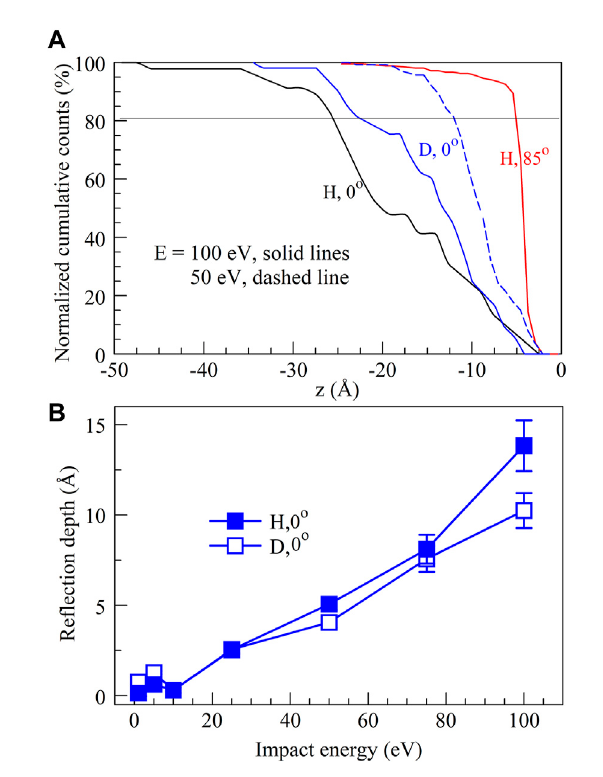
FIGURE 6 (A) Normalized cumulative counts of re fl ection depths of incident H and D atoms inside (A) LiH and (A) LiD surfaces, respectively, for several impact energies and angles. (B) Average re fl ection depths of H and D in (A) LiH and (A) LiD, respectively, for a range of impact energies at 0 o angle of incidence.